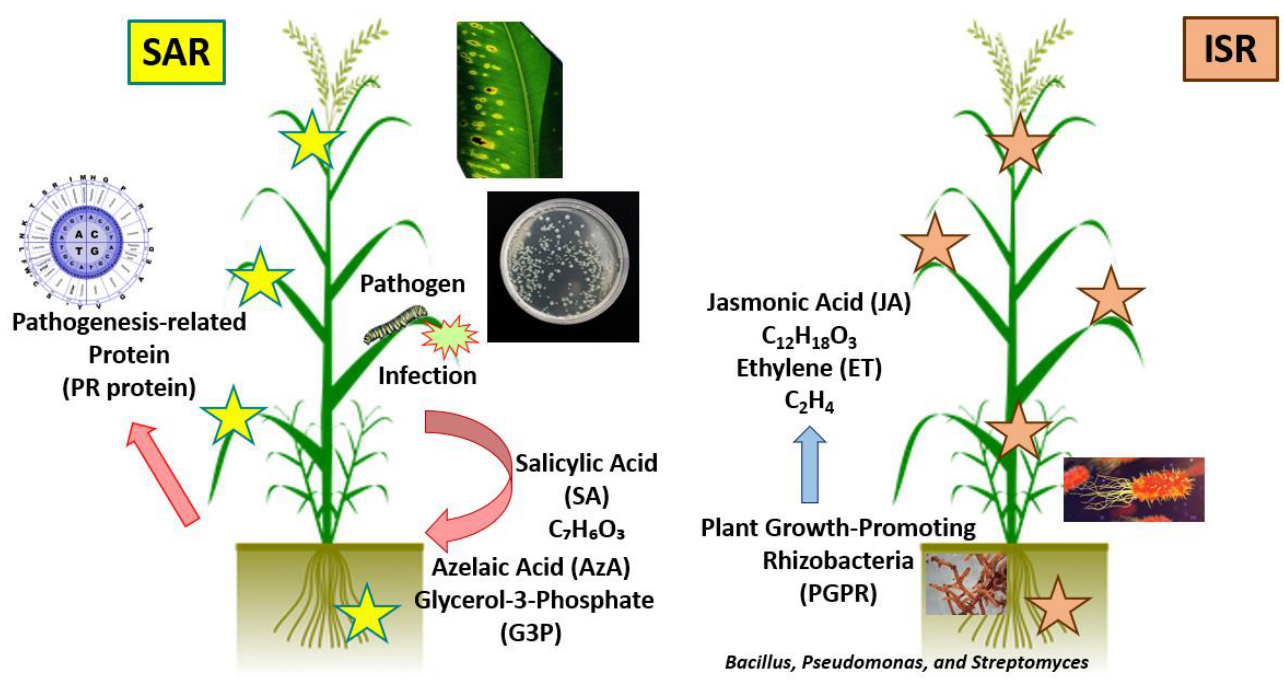
Figure 4. The main plant resistance responses induced at the systemic level. SAR is activated in healthy tissues, distant from the site of infection, and is mediated by SA. ISR is activated in the whole plant following the establishment of symbiosis with beneficial microorganisms at the rhizosphere level and is mediated by JA/ET [141–143].